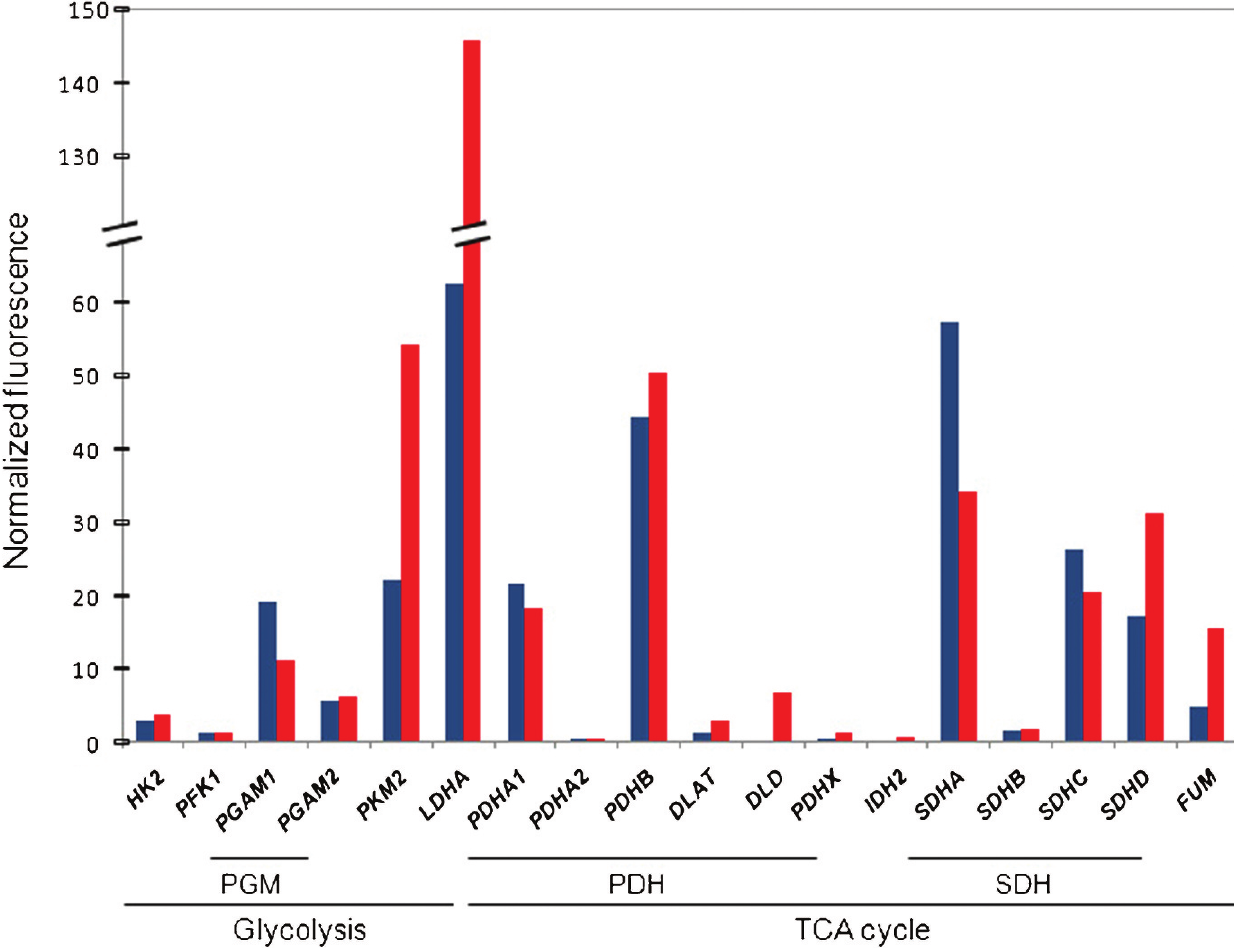
Figure 3 - Oligonucleotide microarray data of genes coding for key enzymes or subunits of enzymatic complexes of glycolysis and the TCA cycle. Three samples of non-tumoral brain tissues (blue bars) and three samples of GBM (red bars) were submitted to extraction of total RNA and microarray analysis, as described previously. 94,146 LDHA and PKM2, both enzymes of glycolysis, are upregulated in GBM, whereas the variability in the expression profile of TCA cycle genes suggests that this cycle is uncoupled. The bars represent the median values of the three samples. Numbers represent the normalized fluorescence. Genes coding for glycolysis enzymes: HK2 , hexokinase 2; PFK1 , phosphofructokinase; PGAM1 and PGAM2 , phosphoglycerate mutase 1 and 2, subunits of PGM dimer; PKM2 , pyruvate kinase M2; LDHA , lactate dehydrogenase A. Genes coding for the TCA cycle enzymes: PDHA1 and PDHA2 , pyruvate dehydrogenase alpha 1 and 2; PDHB , pyruvate dehydrogenase beta; DLAT , dihydrolipoamide-acetyltransferase; DLT , dihydrolipoamide dehydrogenase; PDHX , pyruvate dehydrogenase complex, component X, all six subunits of the enzymatic complex PDH; IDH2 , isocitrate dehydrogenase 2; SDHA , SDHB , SDHC , and SDHD , SDH complex, subunits A, B, C, and D; and FUM ,